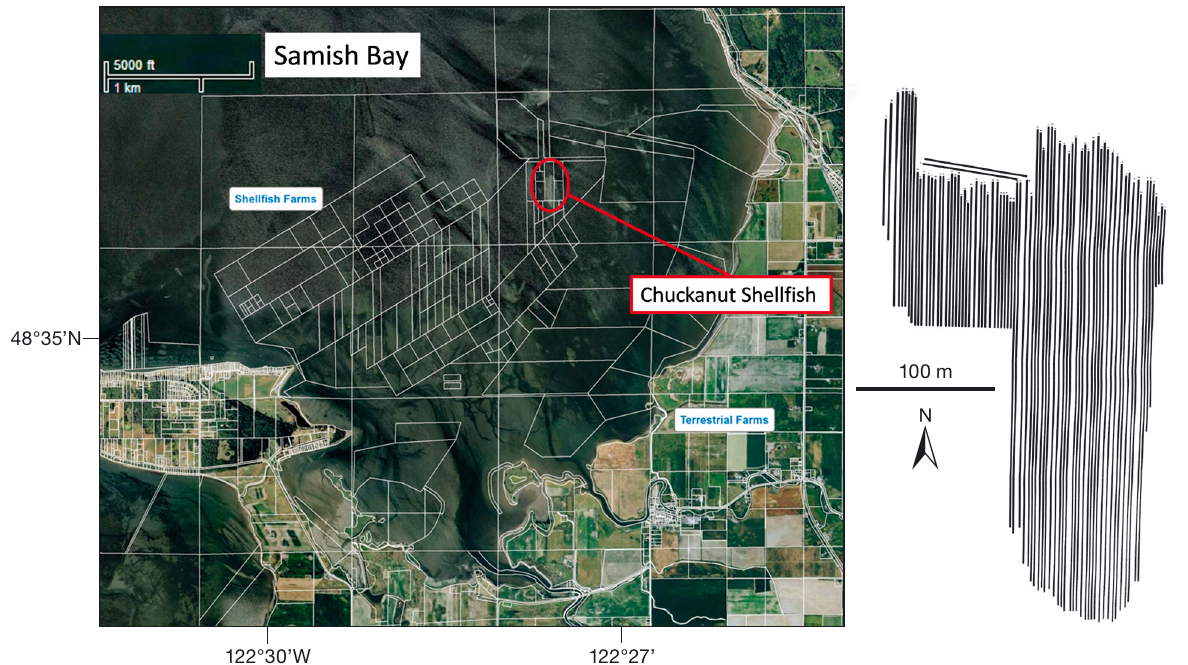
Fig. 1. Chuckanut Shellfish farm location in Samish Bay, northern part of Washington State, USA. (Right) Farm layout, lines represent the cultivated strips. Sampling areas for water quality, clam production and reference sites are contained within or are adjacent to the farm